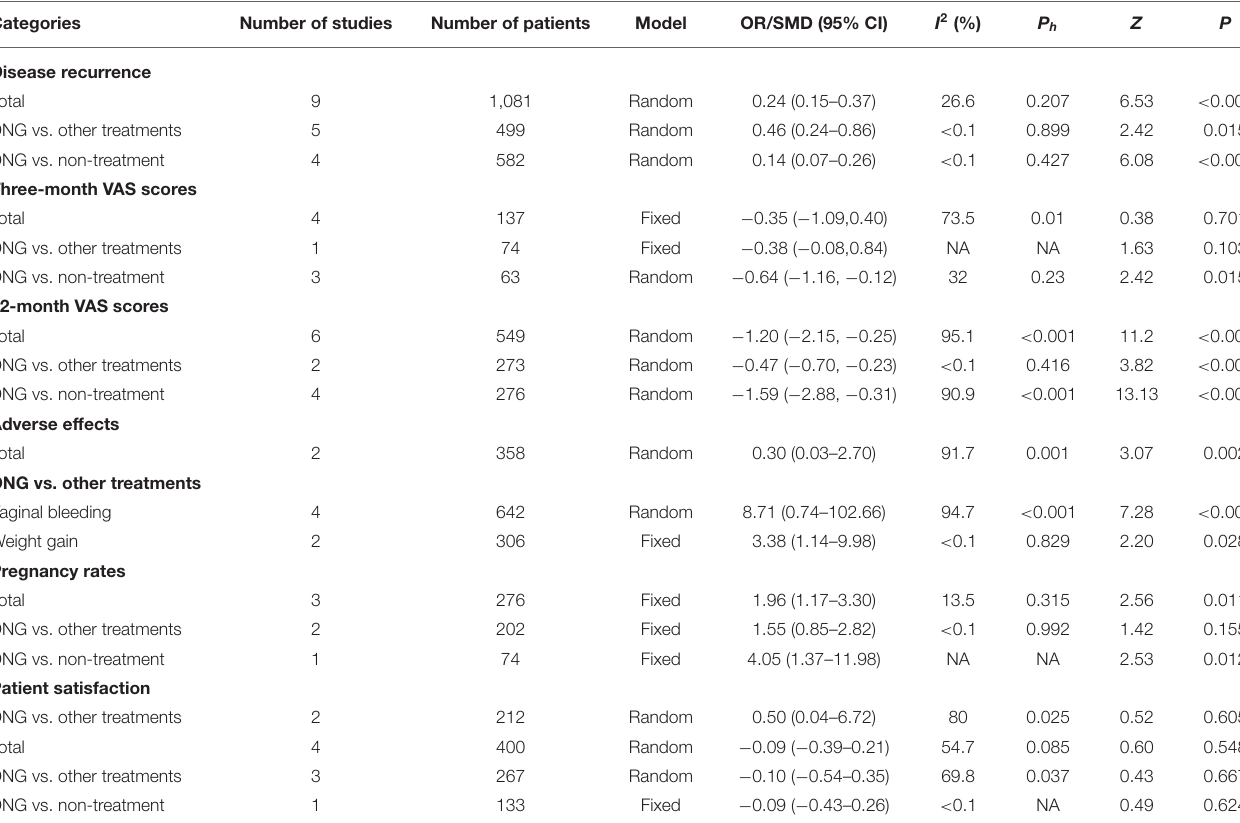
TABLE 3 | Comparison of DNG, OT, and NT in all